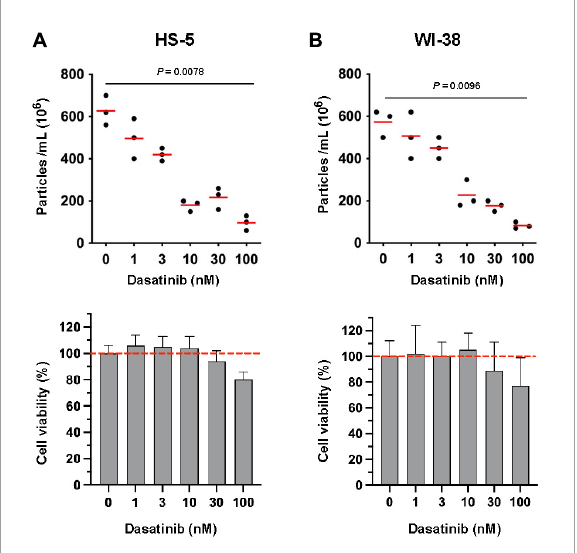
FIGURE1 Influence of tyrosine kinase inhibitor Dasatinib on the release of extracellular vesicles (EVs) in stromal cells. HS-5 (A) and WI-38 (B) cells (2 × 10 6 /ml) were cultivated at 37 ◦ C in serum-free RPMI-1640 with dilution series of Dasatinib as indicated. DMSO (0.1% in PBS) served as a control. After 24 h, cells and the supernatant were separated by centrifugation (10 min, 300 × g ). The supernatant was cleared by centrifugation at 3,000 × g and afterwards subjected to ultracentrifugation (90 min, 110,000 × g ). After ultracentrifugation, the EV pellet was suspended in PBS and the count was determined by nanoparticle tracking analysis. The cell pellet was used for cell viability determination. The viability of the DMSO-treated aliquots served as controls (100%). The statistic evaluation was performed by the Kruskal–Wallis